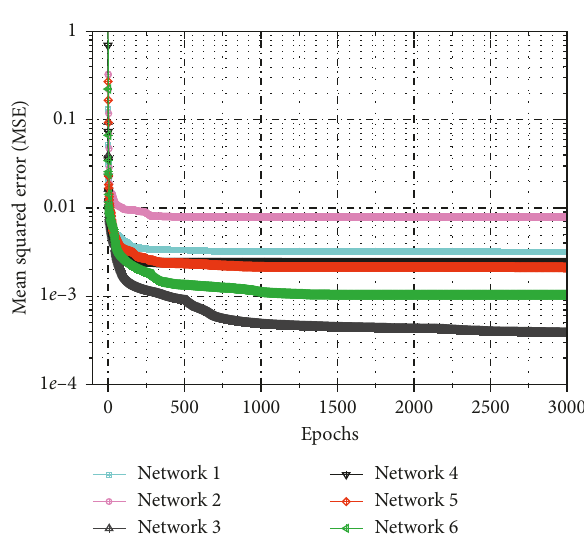
Figure 4: Comparison between six